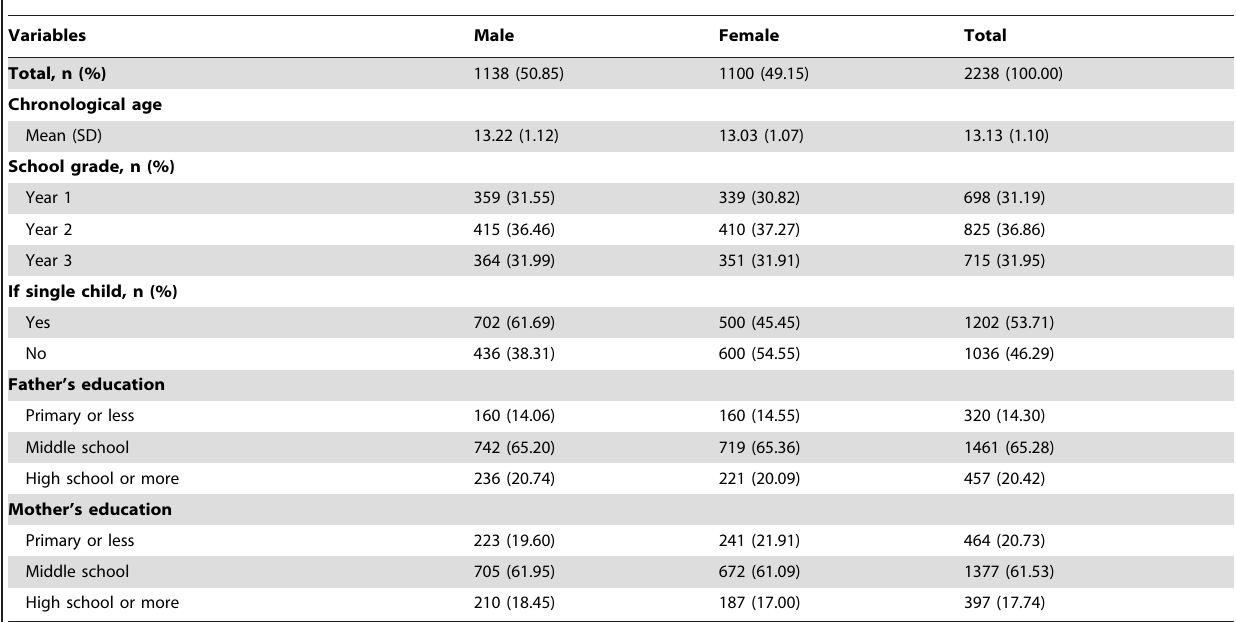
Table 1. Characteristics of the study